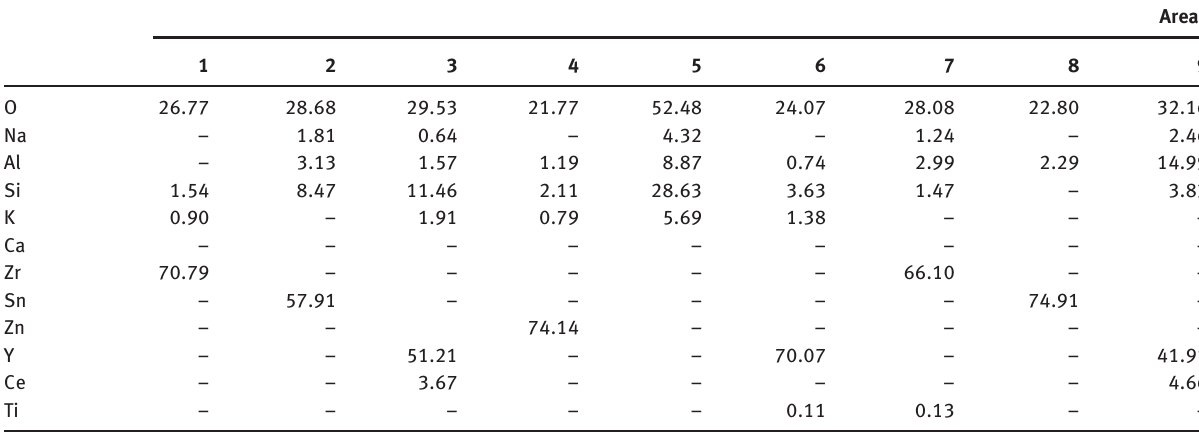
Table 1 Weight percent of elements detected from EDS analysis on representative areas on the surface of the dental porcelain.